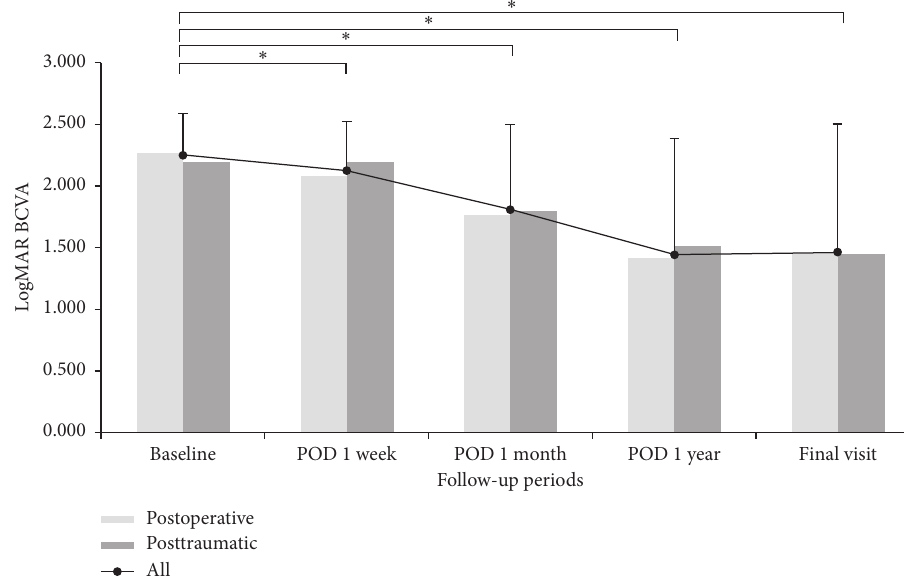
Figure 1: Mean logMAR (logarithm of the minimum angle of resolution) best-corrected visual acuity (BCVA) changes during follow-up. Mean BCVA was significantly improved after surgery than baseline (repeated measures analysis of variance corrected by the Bonferroni method) but not significantly different between the postoperative and posttraumatic groups during the follow-up periods (Student’s t